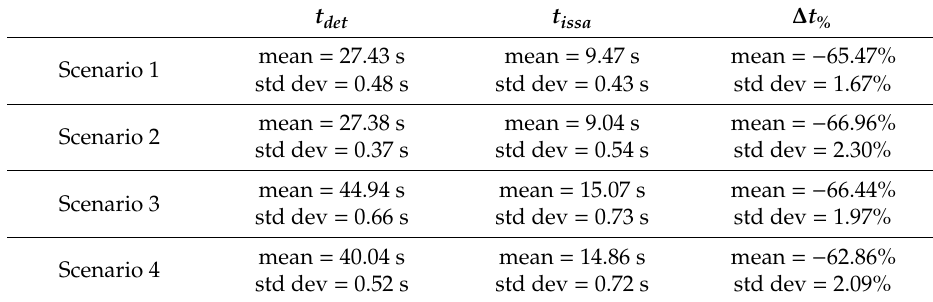
Table 5. Execution time performance evaluation, case A (simulation time step 1 ∙ 10 − 6 s), Computer 2*. t det t issa Δ t %